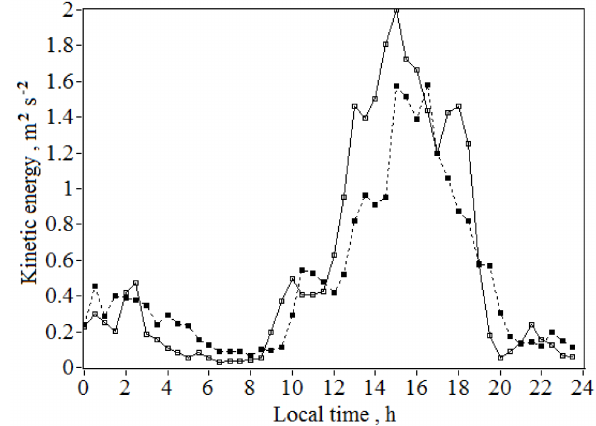
Figure 14. Diurnal profiles of the kinetic energy of turbulence ob- tained from simultaneous measurements by the sonic anemometer at a height of 43m (solid curve) and the Stream Line lidar at a height of 100m (dashed curve) on 27 August